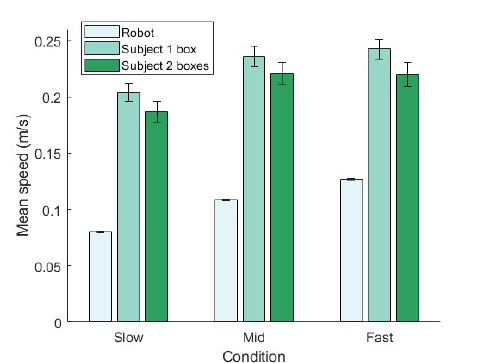
Figure 7: Mean speed of the robot and subjects in all conditions in Japan. Error bars represent standard